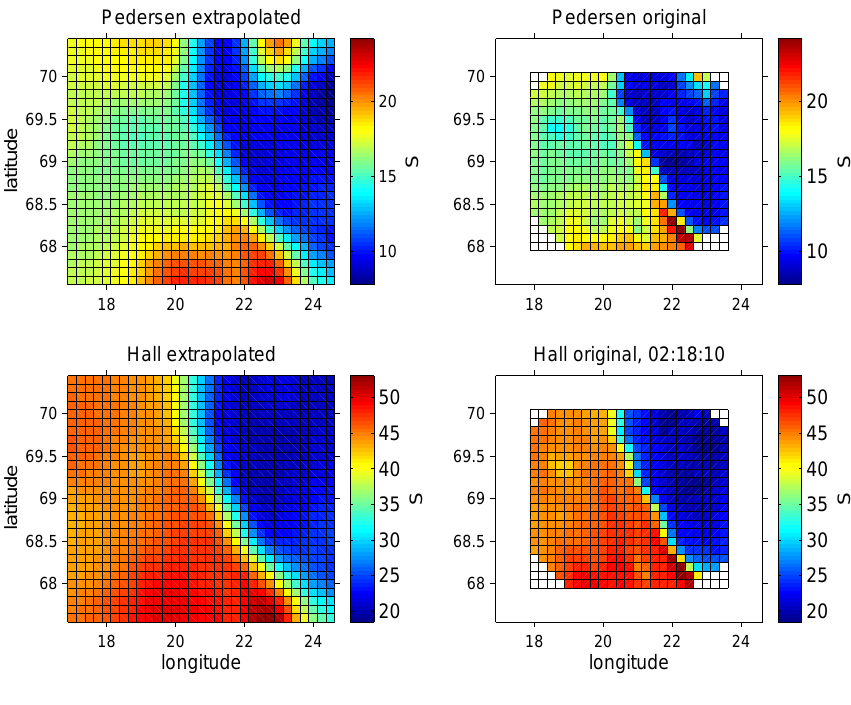
Fig. 2. Example of the original emap conductance data for one time step (panels on the right). In order to be used in the local KRM method the conductance data is extrapolated to a larger grid and smoothed to match the spatial resolution of the equivalent current data (panels on the